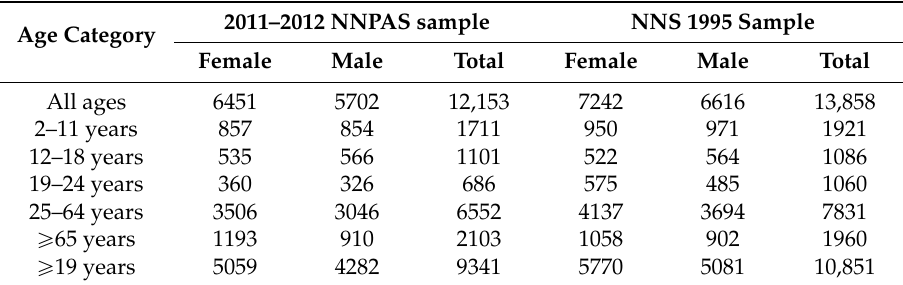
Table 1. Total number of study participants per sex and age and